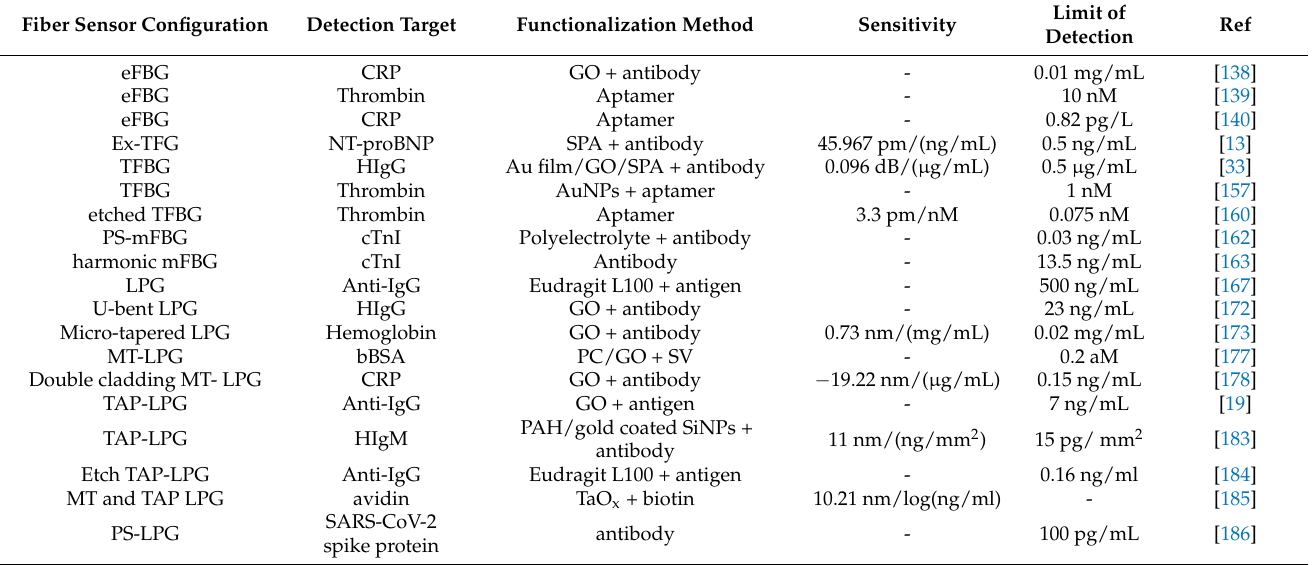
Table 4. Fiber grating-based fiber biosensors for protein detection. Fiber Sensor